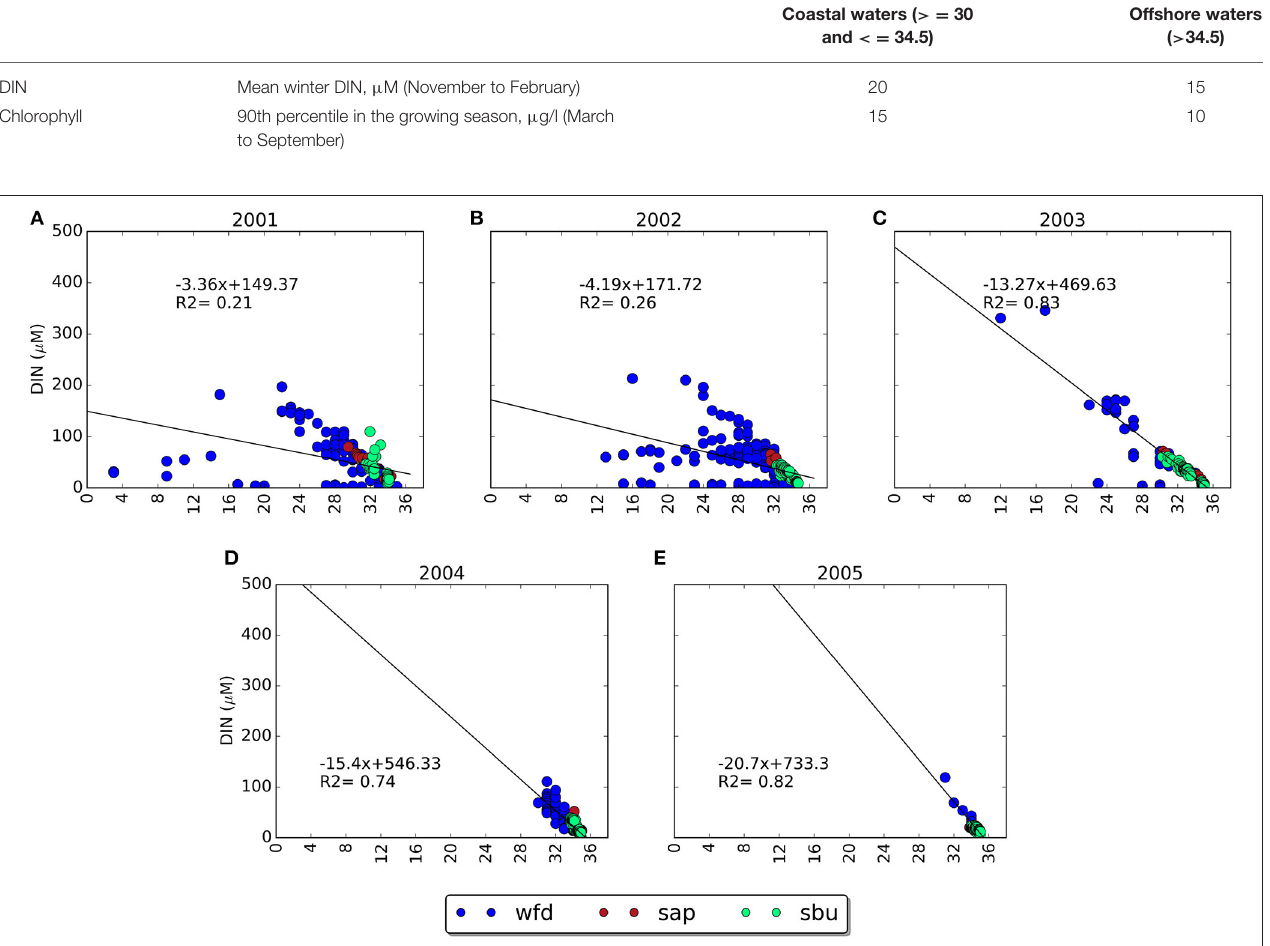
FIGURE 3 | Mixing diagrams and linear regression adjustment for DIN in East Anglia (OSPAR COMP2), years 2001 to 2005 (A–E)